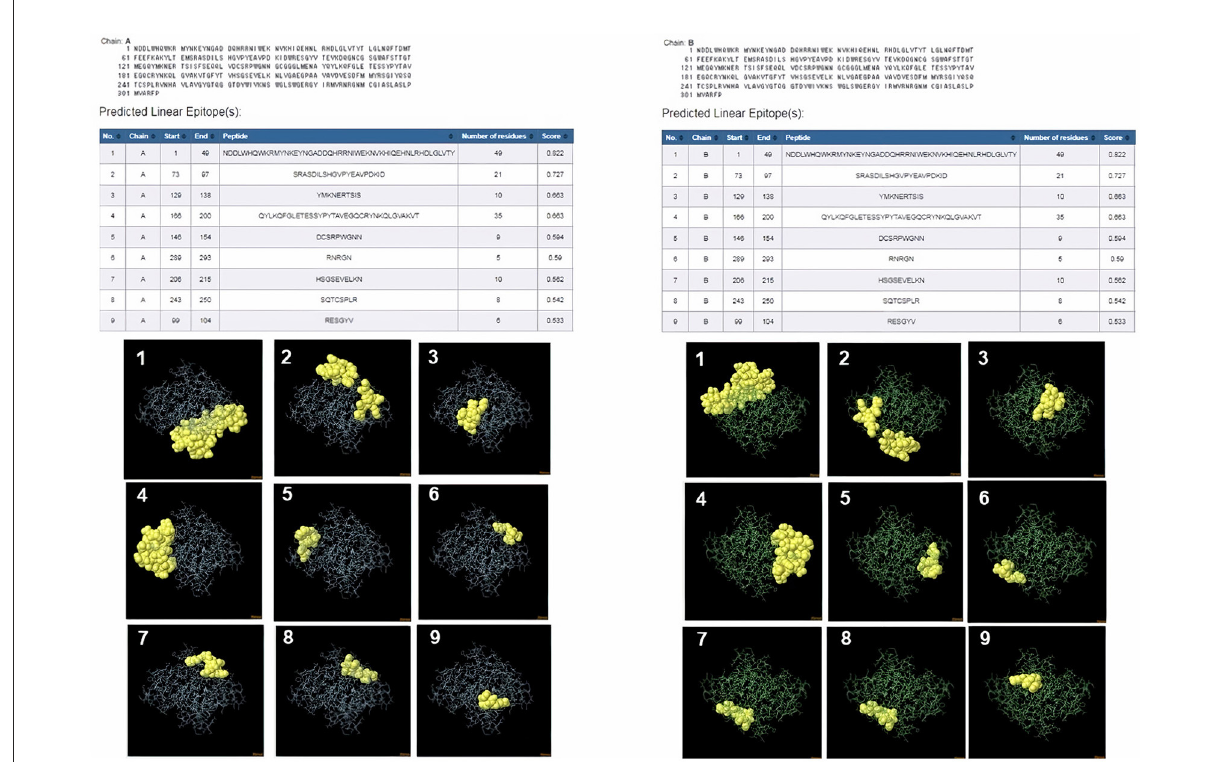
FIGURE8 ElliPro: Linear antibody epitope 3D structures prediction of FhCatL1. Crystal Structure of ProCathepsin L1 from Fasciola hepatica (206X.1A) chain A PDB file was used as input data for ElliPro searches. Input sequence, table of predicted epitopes, and Jmol visualization of the 9 predicted epitopes shows the epitope residues are in yellow and the rest of the protein is in violet (left panel) . Crystal Structure of ProCathepsin L1 from Fasciola hepatica (206X.1B) chain B PDB file was used as input data for ElliPro searches. Input sequence, table of predicted epitopes, and Jmol visualization of the 9 predicted epitopes shows the epitope residues are in yellow and the rest of the protein is in green (right panel) (http:// tools.iedb.org/ellipro/).